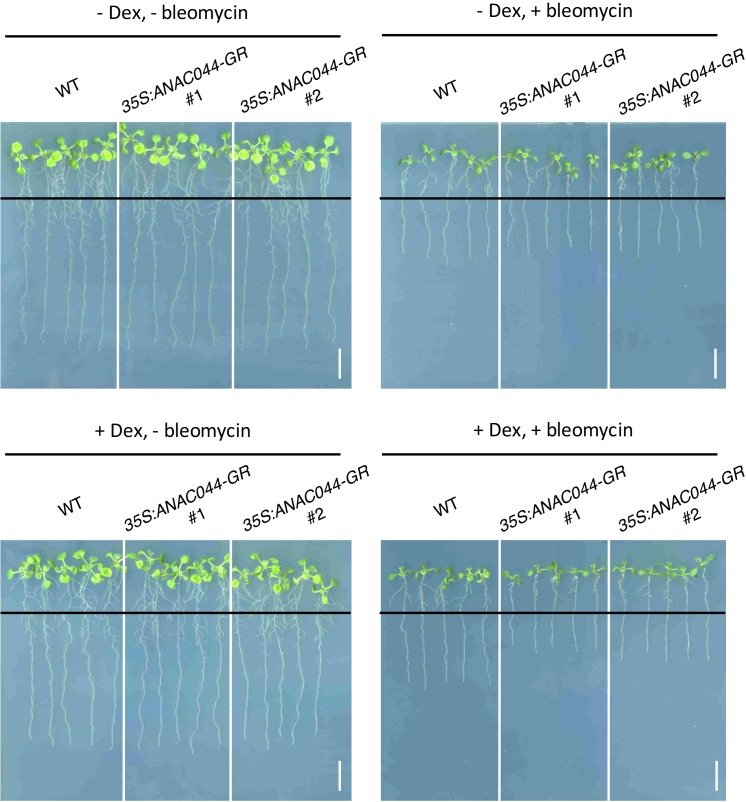
Root growth of 35S:ANAC044-GR seedlings.Five-day-old seedlings were transferred to medium with or without 10 µM Dex and/or 0.6 µg/ml bleomycin, and grown for a further five days. Black lines indicate the positions of root tips when seedlings were transferred onto each medium. Bar = 1 cm.